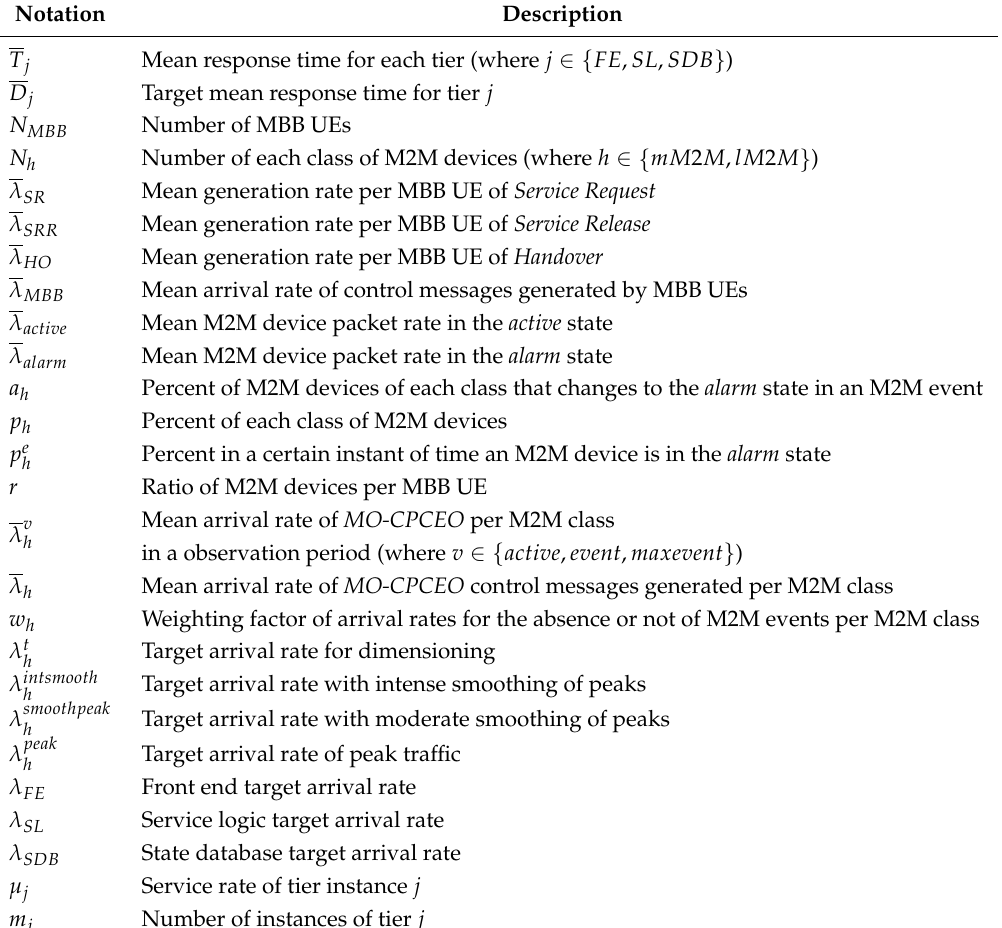
Table 1. Primary definitions. FE, Front End; SL, Service Logic; SDB, State Database; MBB, Mobile Broadband; UE, User Equipment; mM2M, massive M2M; MO-CPCEO, Mobile-Originated Control Plane Cellular IoT Evolved packet system